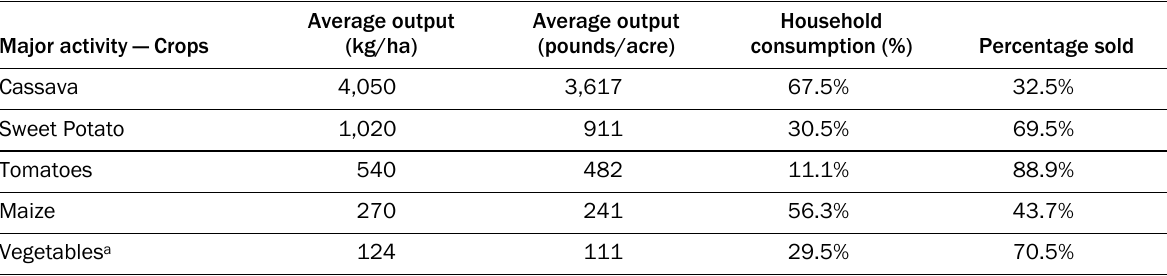
Table 1. Average Production in Kilograms per Hectare and Acre, and Percentage of Consumption and Sales